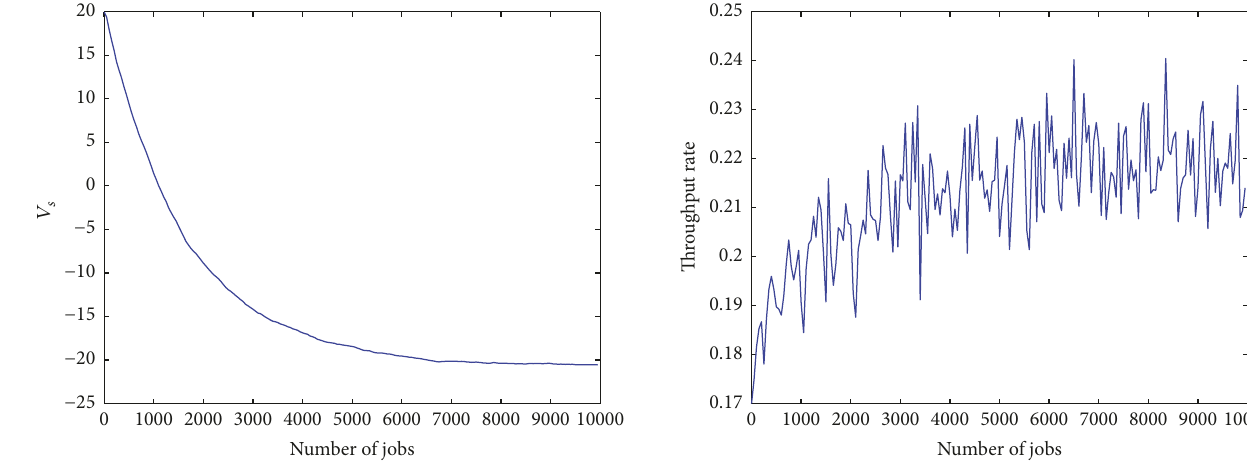
Figure3:Variationof 𝑉 𝑠 withrespecttothenumberoffinishedjobs.